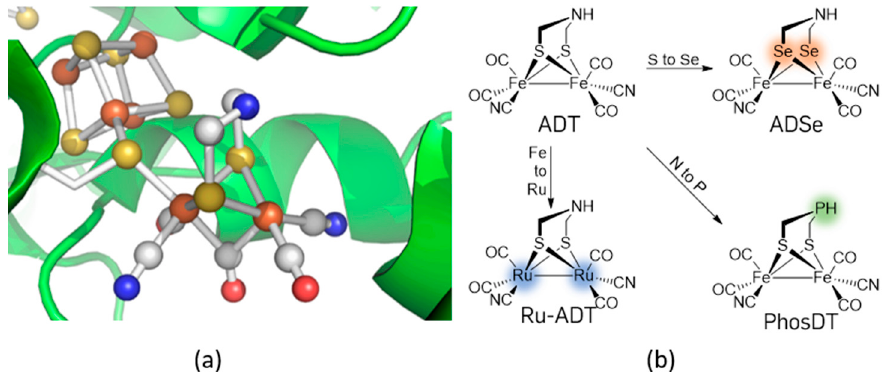
Figure 1. ( a ) Active site of [FeFe]-hydrogenases known as H-Cluster. Color code: white: carbon, blue: nitrogen, red: oxygen, yellow: sulfur, orange: iron; ( b ) Alterations within the diiron subsite based on the principle of element homologue replacement. Therein, the ADSe and Ru-ADT derivatives are already known from our and other groups.